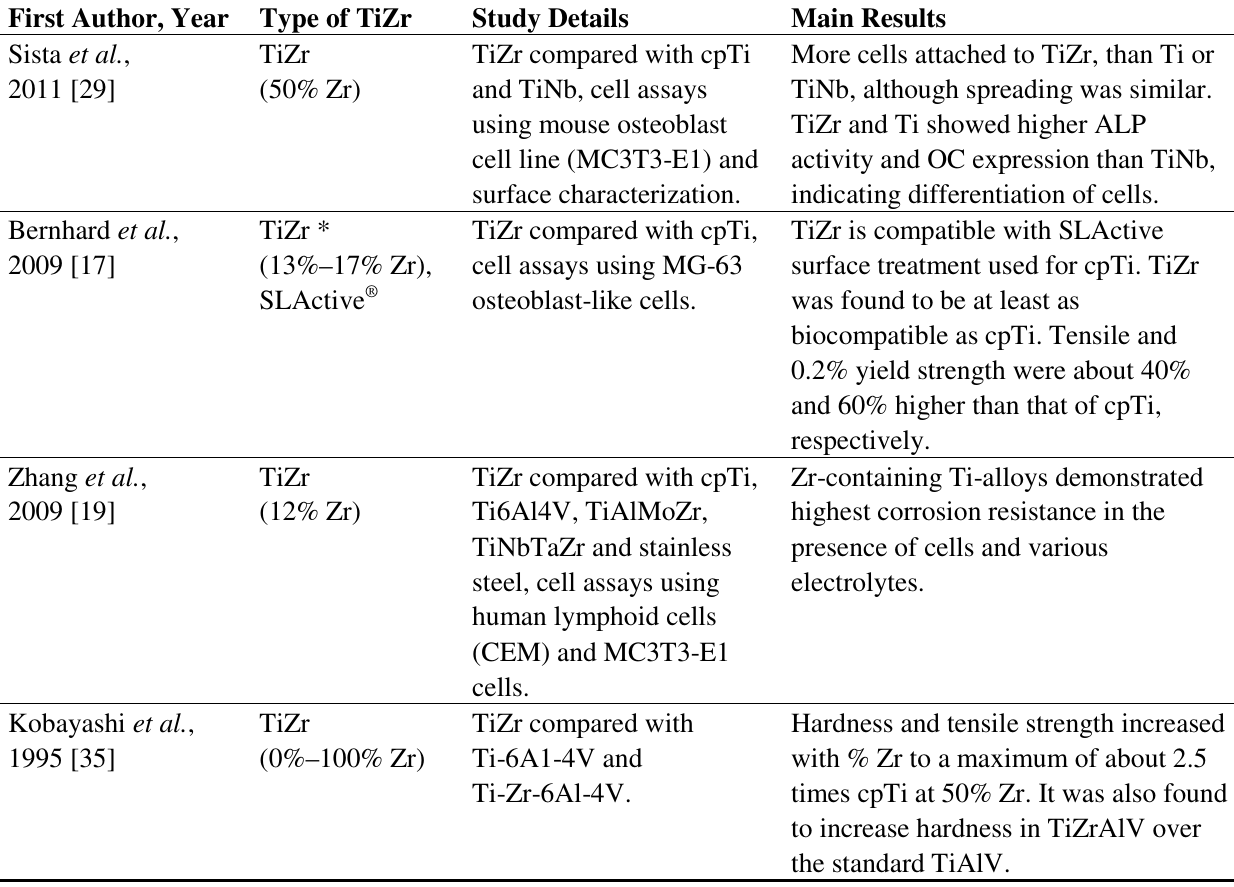
Table 1. In vitro studies of TiZr dental